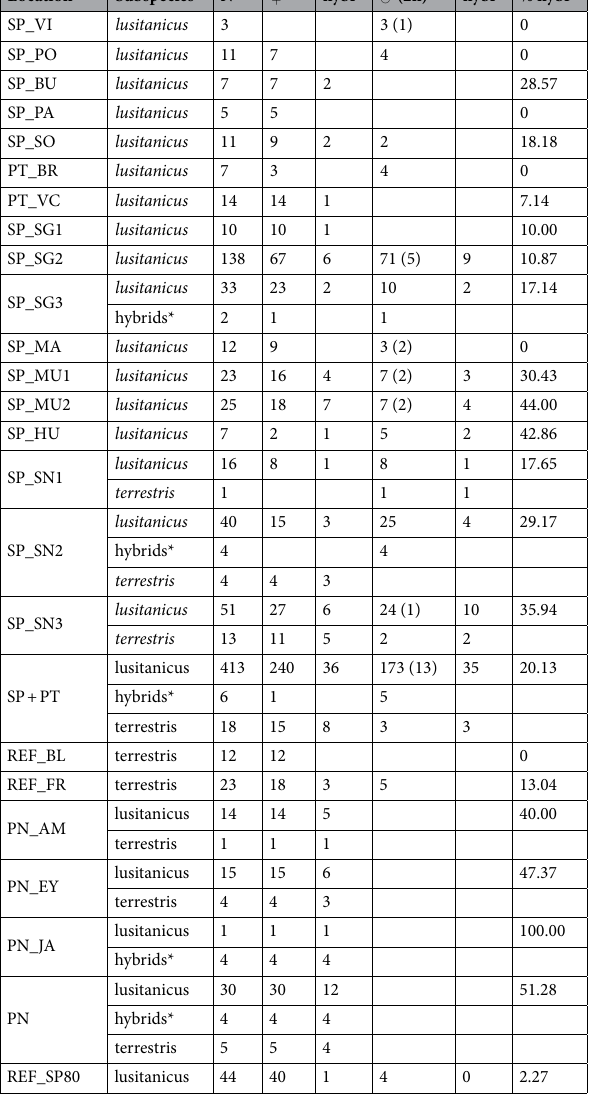
was determined by the nad2 -RFLP approach in 433 individuals (78.01%), by sequencing the Bter_rrnL fragment in 33 individuals (5.95%) and by the 16S fragment in 89 individuals (16.04%) from previous studies 23,39 . Two haplotypes were detected: a haplotype more frequent in the Spanish and Portuguese populations (the Iberian haplotype, SP + PT: 81.70%) and one more frequent in the Belgian and French populations (the central- European haplotype, REF_BL: 100%; REF_FR: 86.96%) (Fig. 1). A different haplotype from that expected based on individuals’ morphology (discrepant hybrid) was detected in 20.13% of the analysed individuals in the pen- insula. B. t. lusitanicus individuals with the central-European haplotype (discrepant hybrids) were found in 12 of the 17 Iberian locations sampled (0% to 44%) and the Pyrenees (18.74%). 61.1% of the naturalized B. t. terrestris found in the south of the peninsula bore the Iberian haplotype. Higher percentages of discrepant hybrids were found in the two intergradation areas: the Pyrenees (PN_JA: 100%; PN_EY: 47.37%; PN_AM: 40.00%) and the southern peninsula (SP_MU2: 44.00%; SP_SN3: 35.94%), while three individuals from France presented the Iberian haplotype (REF_FR: 13.04%) and no hybrids were found in the Belgian reference group. In the historical population, the central-European haplotype was found only in one individual close to the intergradation area of the Pyrenees (Iberian haplotype in REF_SP80: 97.73%).